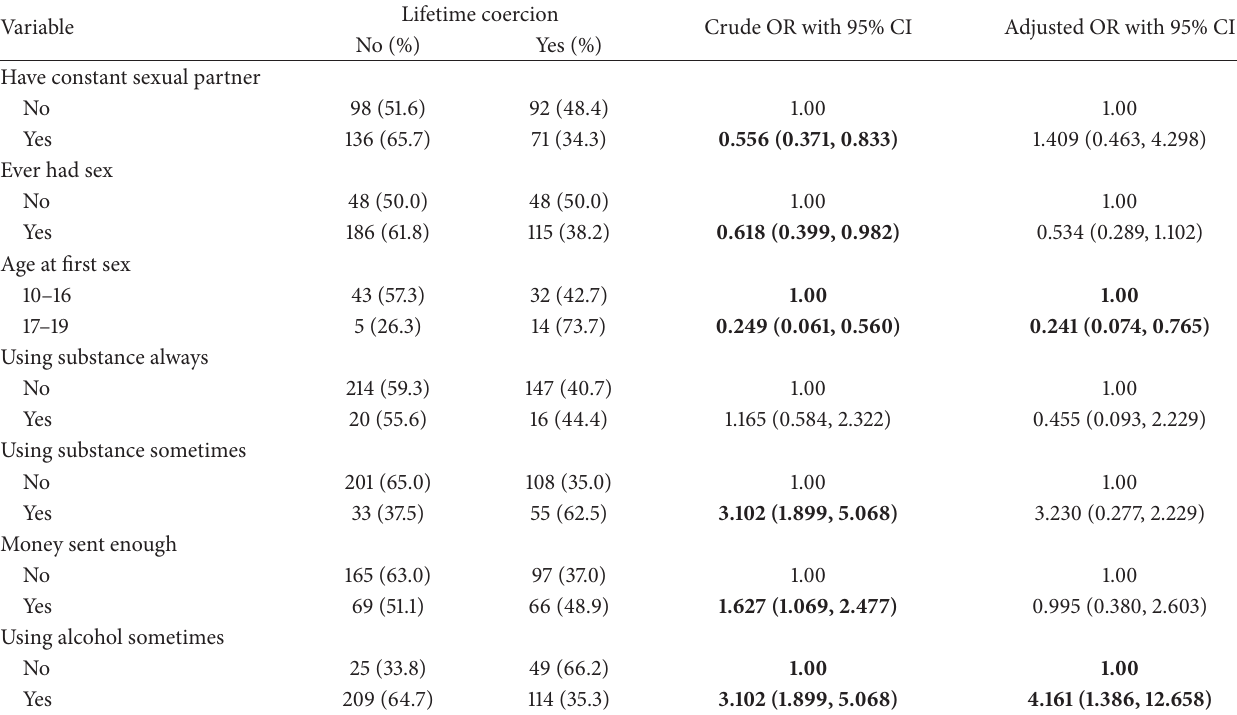
Table 6: Association of lifetime coercion and behavioral characteristics of respondents in Madawalabu University, southeast Ethiopia, May